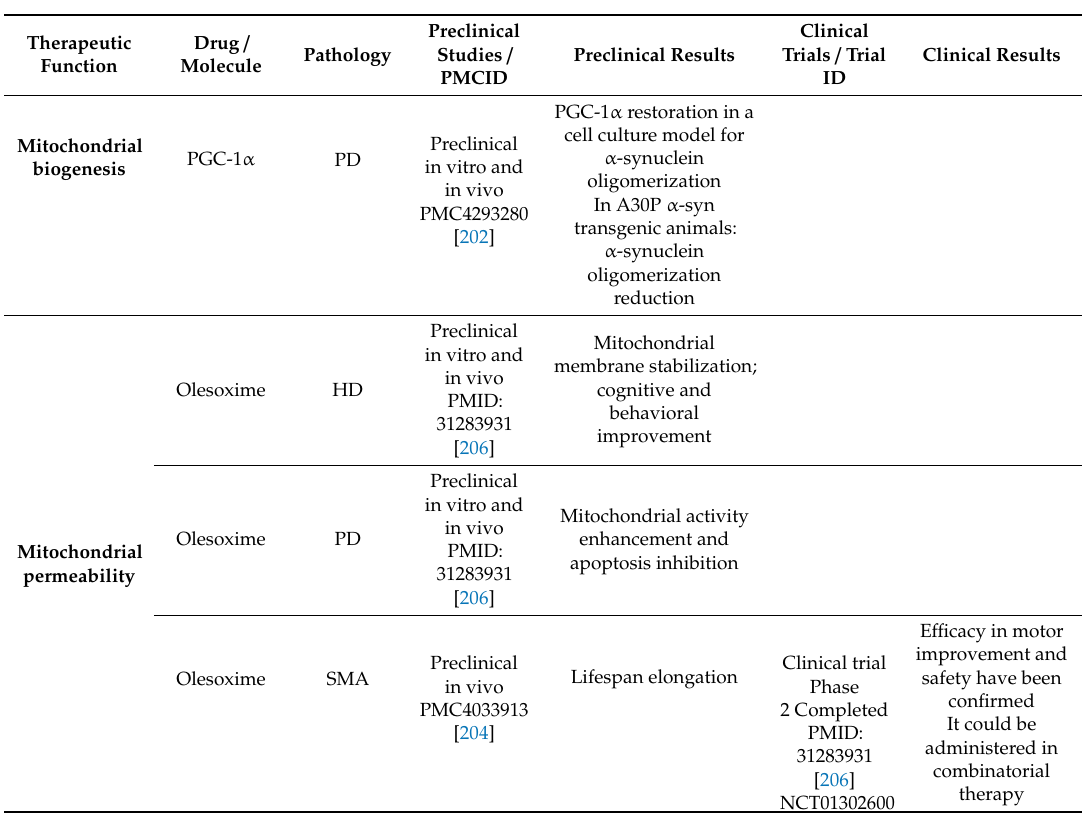
Table 3. Compounds acting on mitochondrial biogenesis and permeability. The table shows the promising experimental results obtained in vitro and / or in vivo after the administration of PGC-1 α (to enhance mitochondria biogenesis) and Olesoxime (to regulate mitochondria permeability). The latter one already gave promising results in SMA patients. For clinical trial ID we referred to https: //